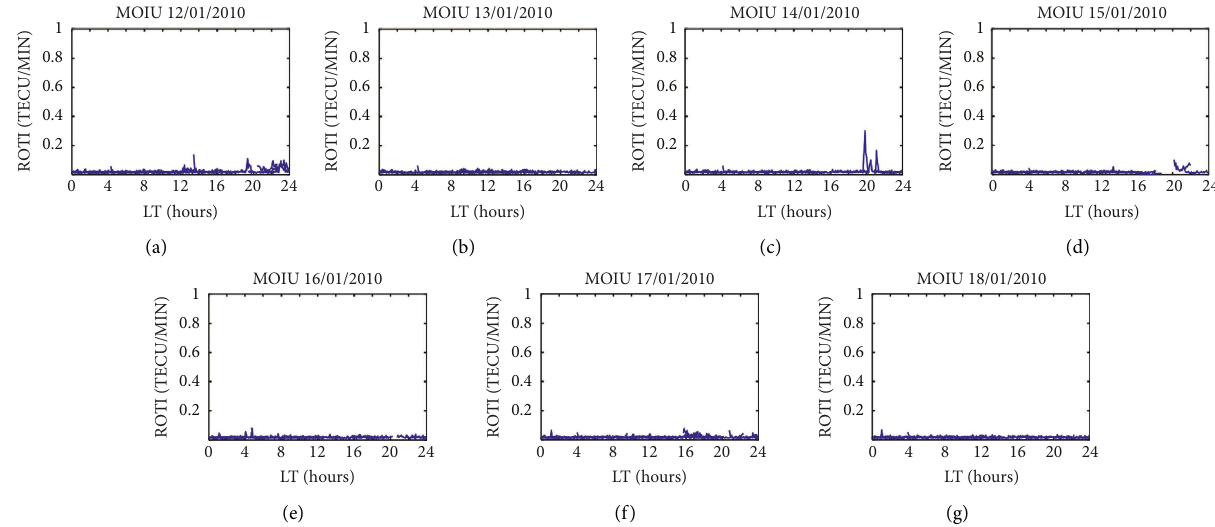
Figure 13: ROTI against LTover MOIU station for (a) 12 th January 2010, (b) 13 th January 2010, (c) 14 th January 2010, (d) 15 th January 2010, (e) 16 th January 2010, (f) 17 th January 2010, and (g) 18 th January 2010.